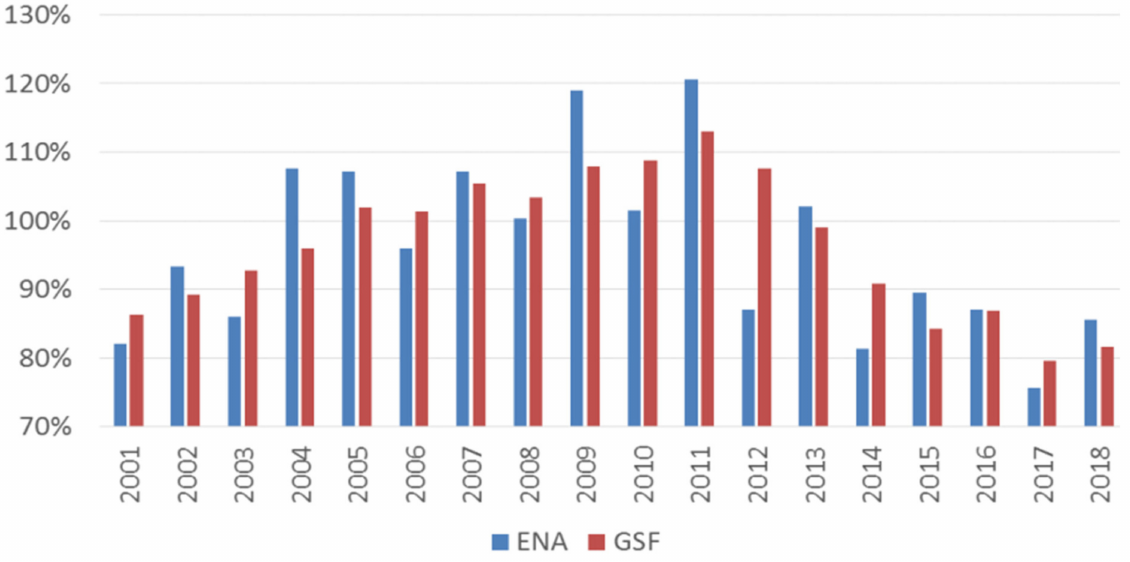
Figure 6. GSF history compared to ENA in BPS